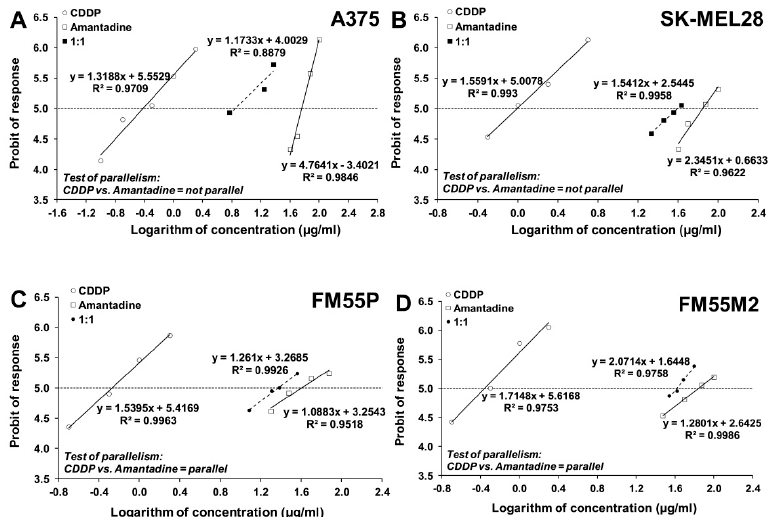
Figure 7. Concentration–response relationship curves (CRRCs) for cisplatin (CDDP) and amantadine administered alone and in combination at a fixed-ratio of 1:1, illustrating the anti-proliferative effects of the drugs in the human malignant melanoma cell lines (A375 ( A ), SK-MEL28 ( B ), FM55P ( C ) and FM55M2 ( D )) measured in vitro by the MTT assay.